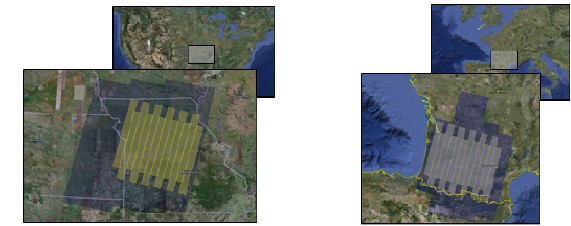
Figure 6 : Footprints of a source images (blue) and associated S2 simulated images (yellow) cases over Missouri (US) and Midi-Pyrenees (FR) areas